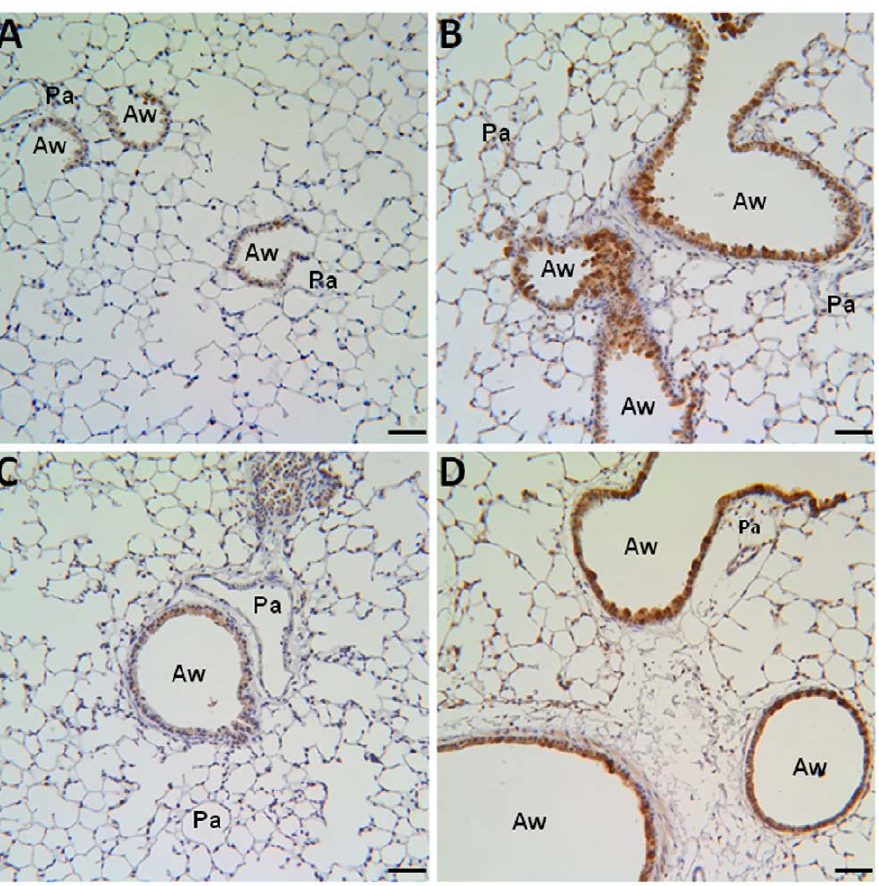
Figure 1. HIMF expression in murine lung. Paraffin-embedded lung sections from normoxic (7d, 20.8% O 2 ) (A), hypoxic (7d, 10.0% O 2 ) (B), AAV- null-treated (14d, 2.5 6 10 10 VP) (C), and AAV-HIMF-treated (14d, 2.5 6 10 10 VP) (D) mice were rehydrated and stained with goat anti-mouse HIMF polyclonal antibodies. Pa: pulmonary artery. Aw: airway. Scale bar: 50 m m.